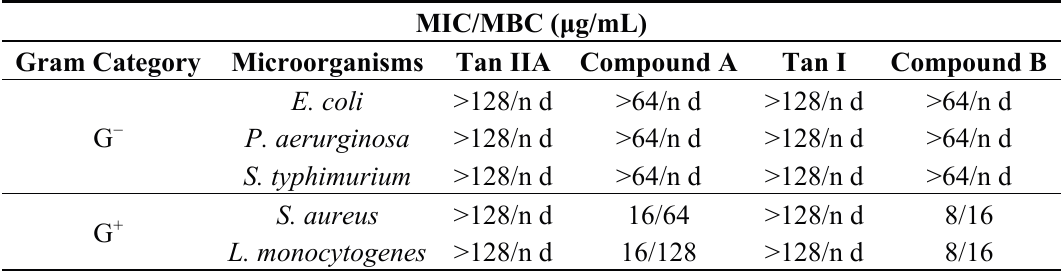
MIC/MBC ( μ g/mL) Gram Category Microorganisms Tan IIA Compound A Tan Ι Compound